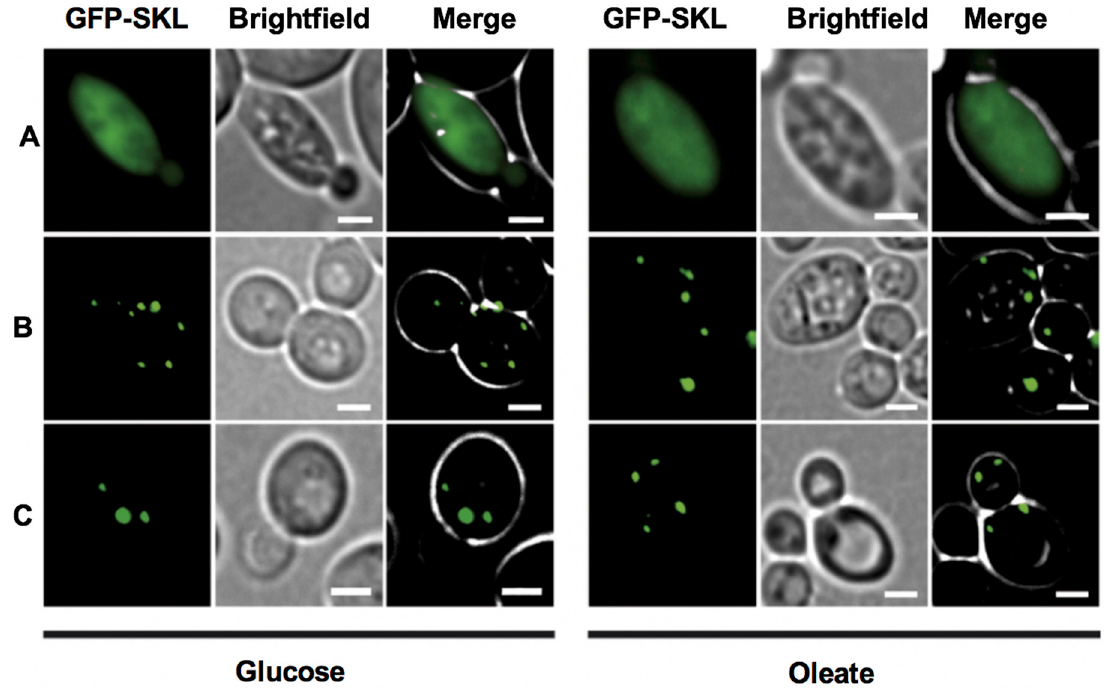
Figure 3. Tg Pex5 complements for the loss of Pex5 in Δ pex5 mutant yeast when grown on medium containing either glucose or oleate as the sole carbon source. No complementation is indicated by a mislocalization of the heterologously expressed GFP-SKL to the cytosol as seen for the empty vector control ( A ). Functional complementation restored peroxisomal import of the GFP-SKL and led to the appearance of a punctate pattern, as seen upon expression of the gene coding for yeast Pex5 ( B ), and the gene encoding Tg Pex5 ( C ). These results indicated that Tg Pex5 can functionally replace the yeast Pex5p in PTS1-protein import into peroxisomes. Scale bar is 5 µm.